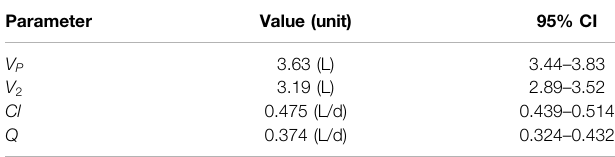
TABLE 4 | GSK3050002 two-compartment PK parameters (Bouma et al., 2017). Parameter Value (unit)